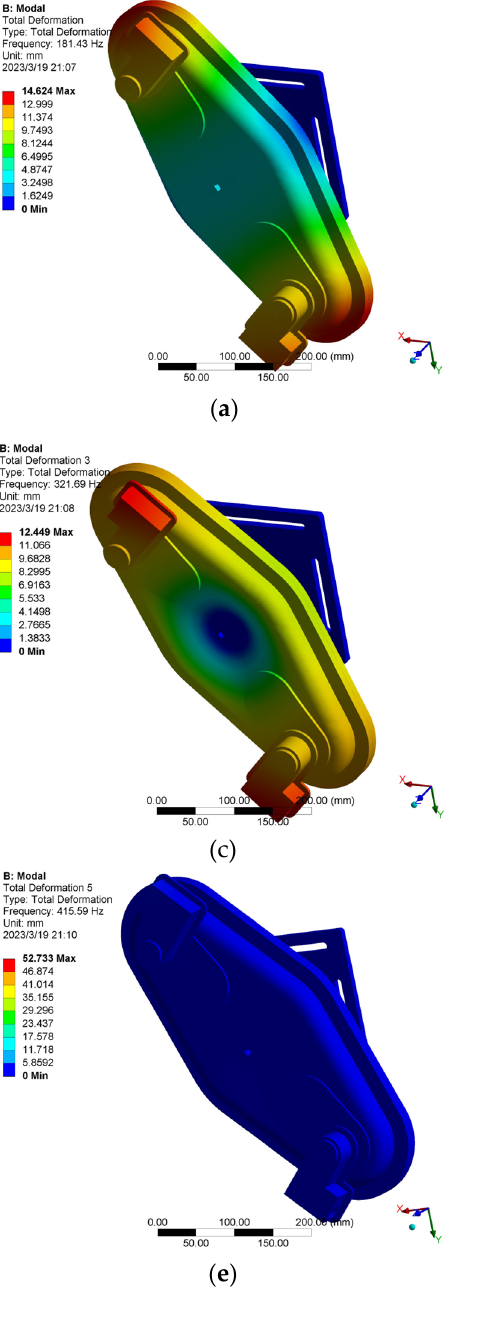
Figure 11. The fi rst sixth-order mode vibration pa tt ern of the seedling picking mechanism: ( a ) First- Figure 11. The first sixth-order mode vibration pattern of the seedling picking mechanism: order modal vibration pa tt ern; ( b ) Second-order modal vibration pa tt ern; ( c ) Third-order modal vi- ( a ) First-order modal vibration pattern; ( b ) Second-order modal vibration pattern; ( c ) Third-order bration pa tt ern; ( d ) Fourth-order modal vibration pa tt ern; ( e ) Fifth order modal vibration pa tt ern; modal vibration pattern; ( d ) Fourth-order modal vibration pattern; ( e ) Fifth order modal vibration ( f ) and Sixth-order modal vibration pa tt ern. pattern; ( f ) and Sixth-order modal vibration Table 3. The fi rst Sixth-order modal frequency of the seedling picking mechanism. Order